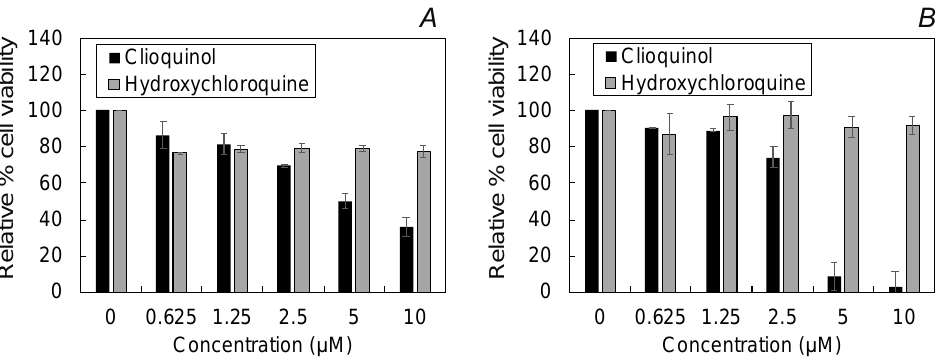
Figure 7. Cell viability after ( A ) 3 and ( B ) 7 days incubation with CQ and HCQ. These experiments revealed that at concentrations higher than 2.5 µM, cell viability was significantly reduced for CQ at both incubation times. Thus, 2.5 µM was selected as the concentrations of CQ and HCQ to be used in the zinc uptake cell assays (below). This value is consistent with reports that HCQ can inhibit viral spread in the Vero cell line (derived from African Green Monkey) [27] at EC 50 values of 0.72 – 17.31 µM [28]. Further- more, pharmacokinetic modelling predicted a mean plasma concentration of HCQ of 2.8